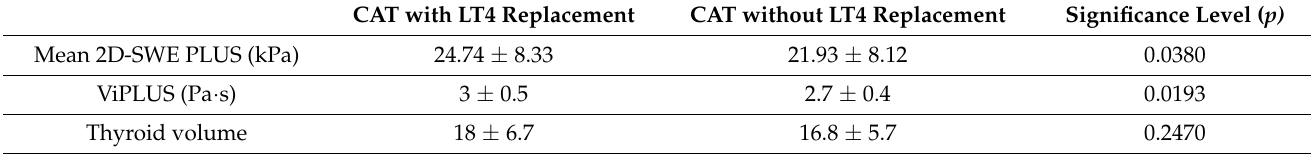
Table 3. Differences of means for the 2D-SWE-based parameters (2D-SWE PLUS and Vi PLUS) for the group with and without levothyroxine replacement therapy.